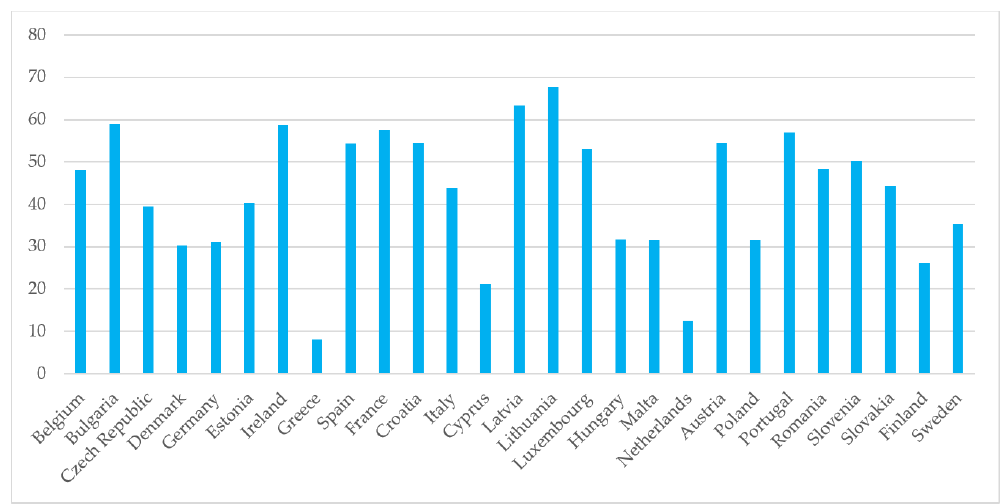
Figure 3. Share of passenger diesel cars in EU countries in 2020, %. Source: [74].